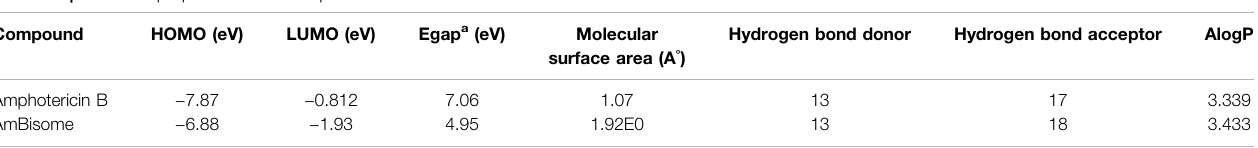
( Figure 4D ) with a docking score of − 283.09 kcal/mol.